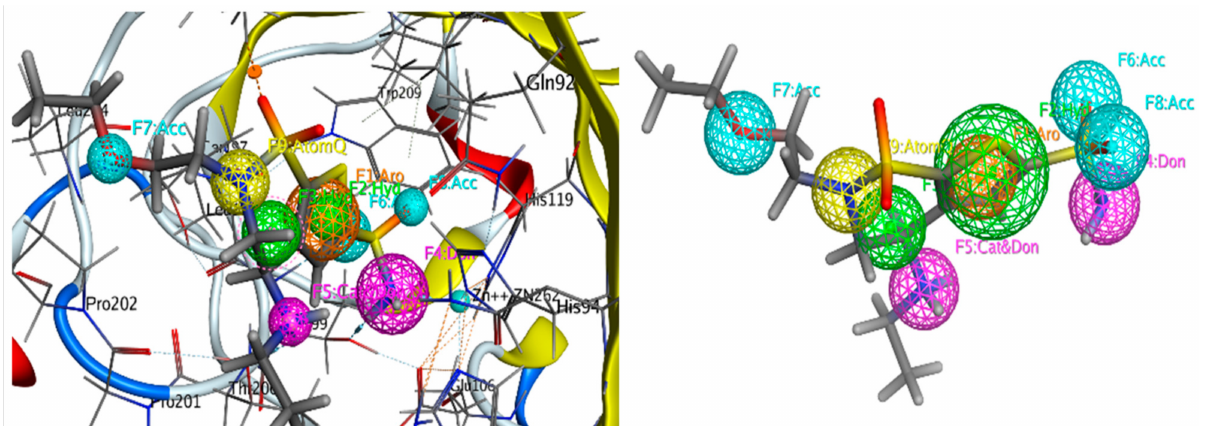
Figure 13. Structure-based pharmacophore model generation of standard brinzolamide inhibitor. The generated features are hydrogen bond acceptor (blue sphere), hydrogen bond donor (pink spheres), hydrophobic (green spheres) and aromatic (orange